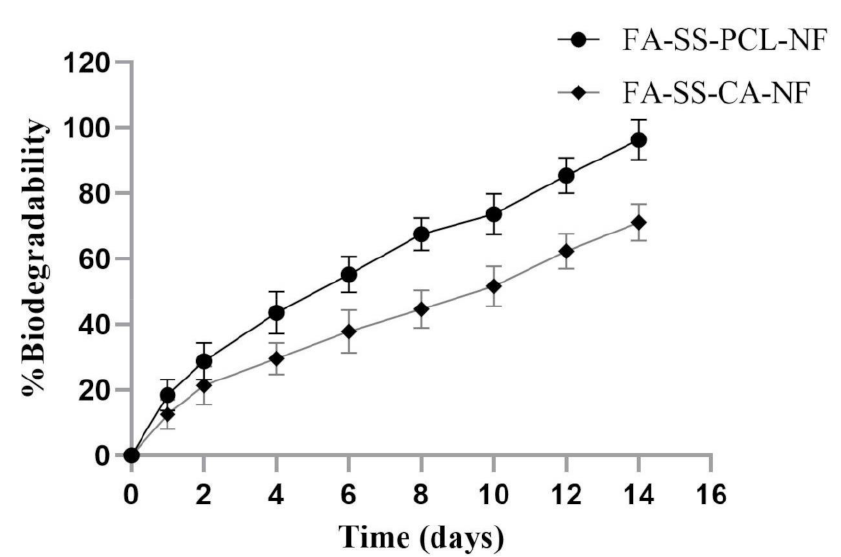
Figure 4. Percentage biodegradability of optimized nanofibrous formulations FA-SS-PCL-NF and FA-SS-CA-NF in PBS at pH7.4 (mean ± S.D.).